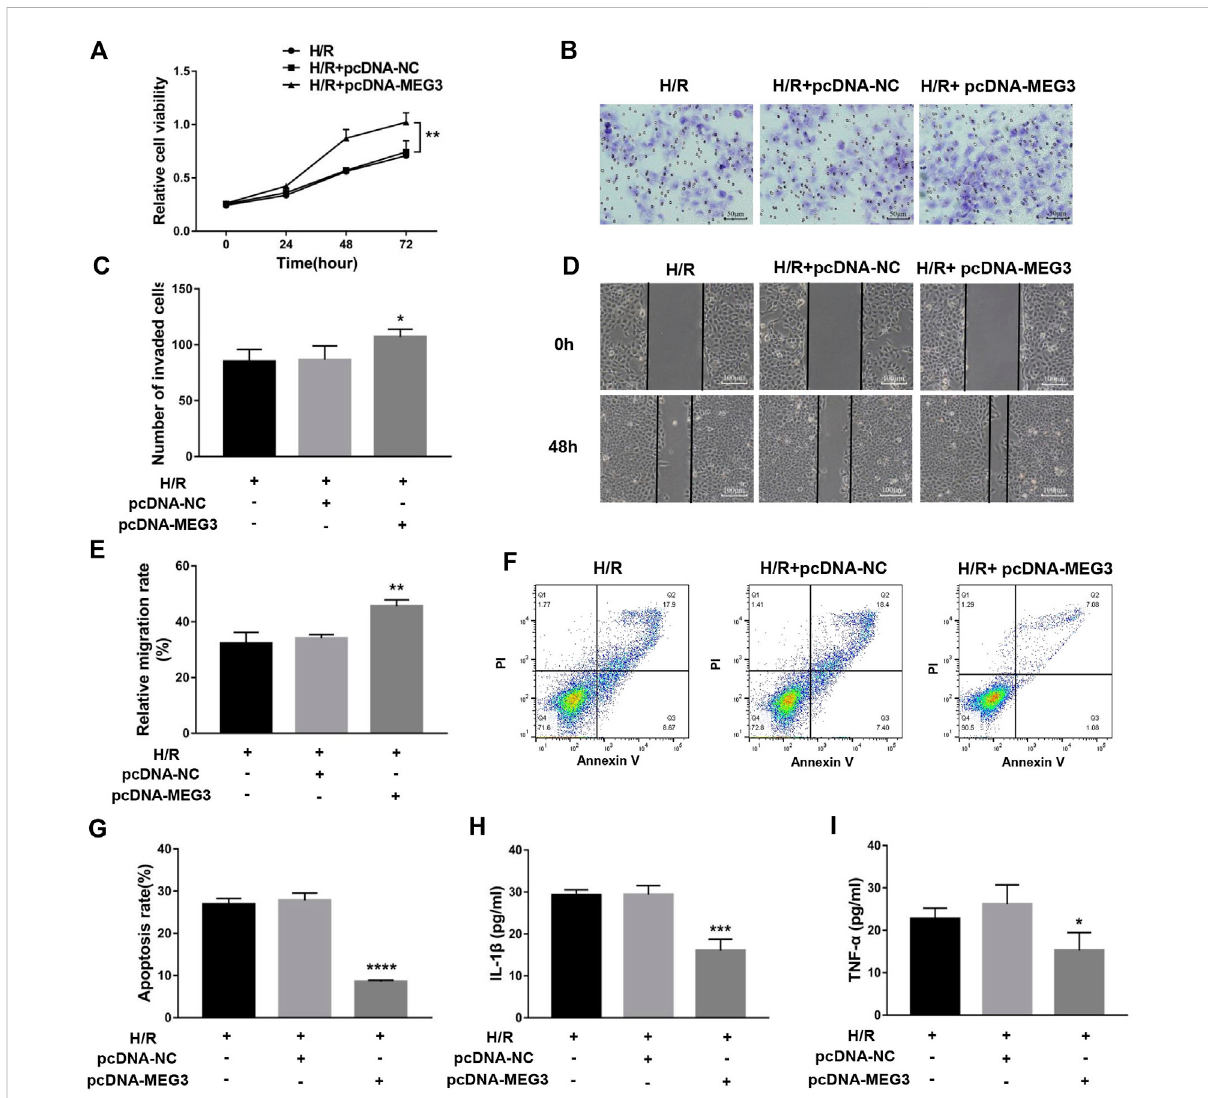
FIGURE 5 The overexpression of MEG3 overcame H/R-induced trophoblast dysfunction and in fl ammatory cytokine secretion. (A) Cell proliferation was determined by CCK-8 assay. (B,C) Cell invasion ability was determined by transwell assay. (D,E) Cell migration ability was determined by scratch assay. (F,G) The apoptosisrate wasmeasuredby fl owcytometry.ELISAwasused tomeasure IL-1 β (H) and TNF- α (I) levels inthecellsupernatant. n = 3/group. * p < 0.05; ** p < 0.01; *** p < 0.001; **** p <